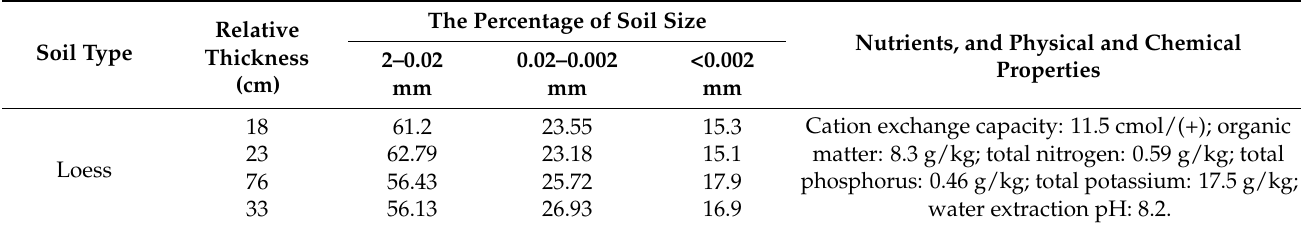
Table 1. Typical characteristics of soil in HRB.